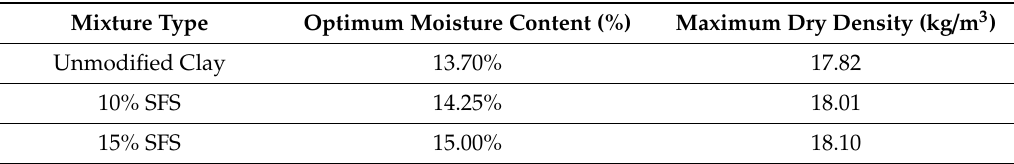
Table 7. Optimum moisture content and maximum dry density values for the unmodified and SFS-modified clay.